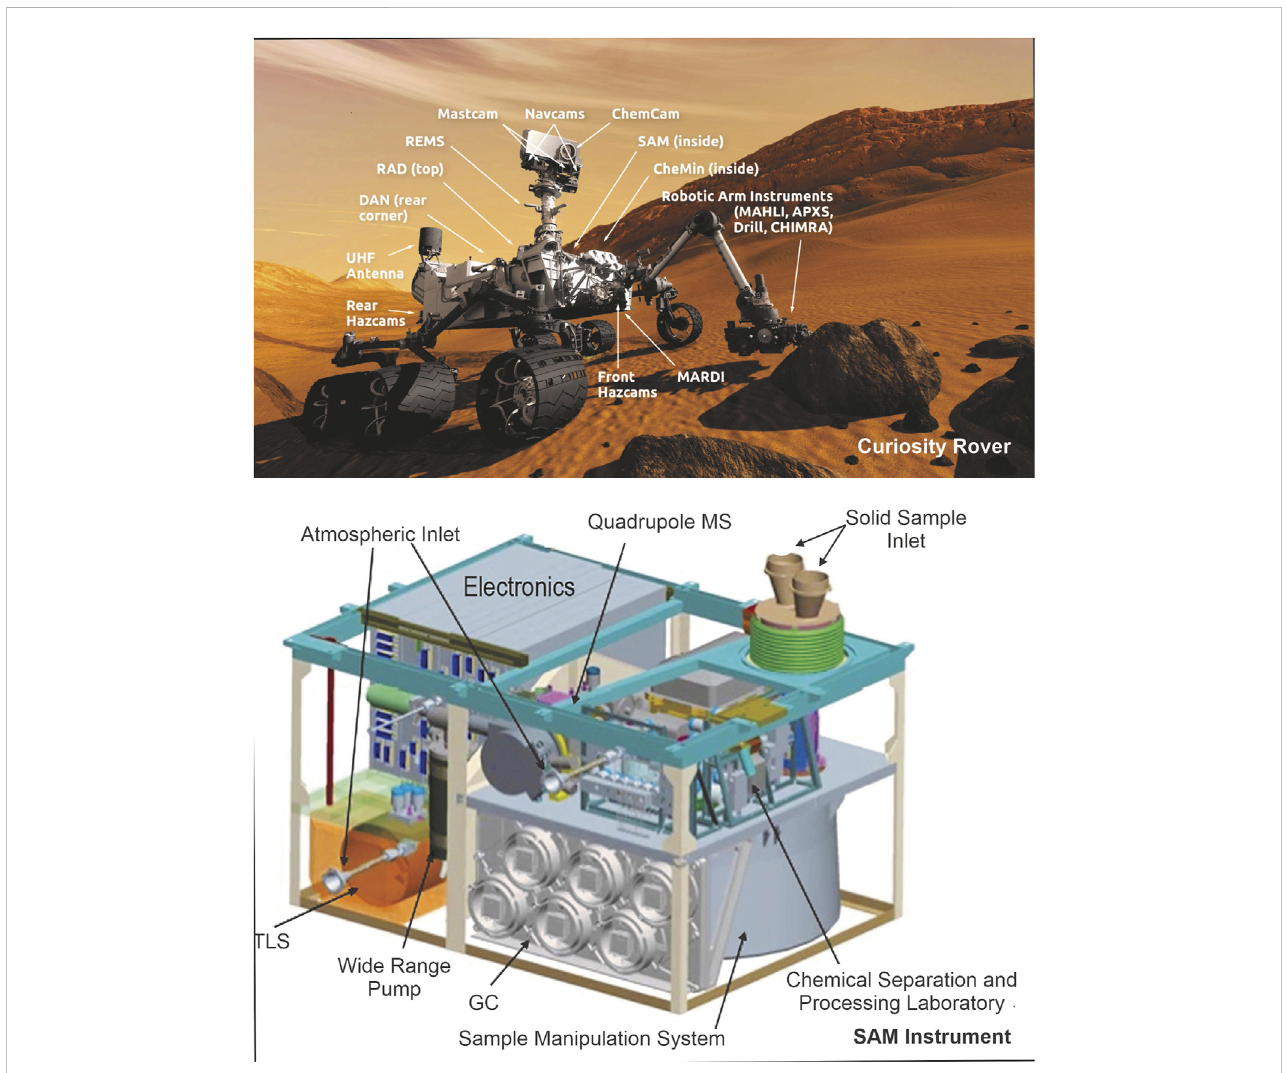
FIGURE 3 Curiosity Rover and SAM instruments [sources: Huidobro et al. (2022) and NASA (2012)].